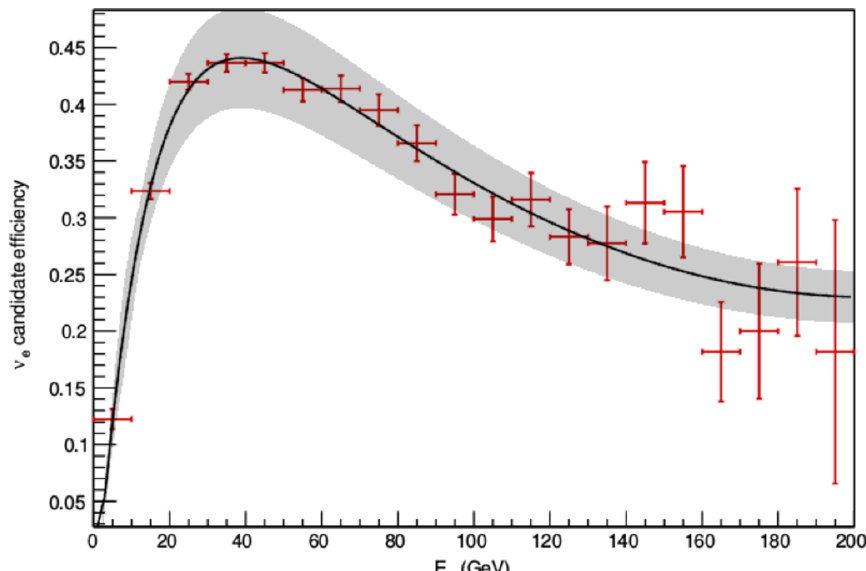
Figure 1 . The (cid:23) e CC candidate selection e(cid:14)ciency as a function of the neutrino energy. Error bars indicate the MC statistical errors. The black line is a (cid:12)tted curve to the simulated e(cid:14)ciency points and the grey area represents the systematic